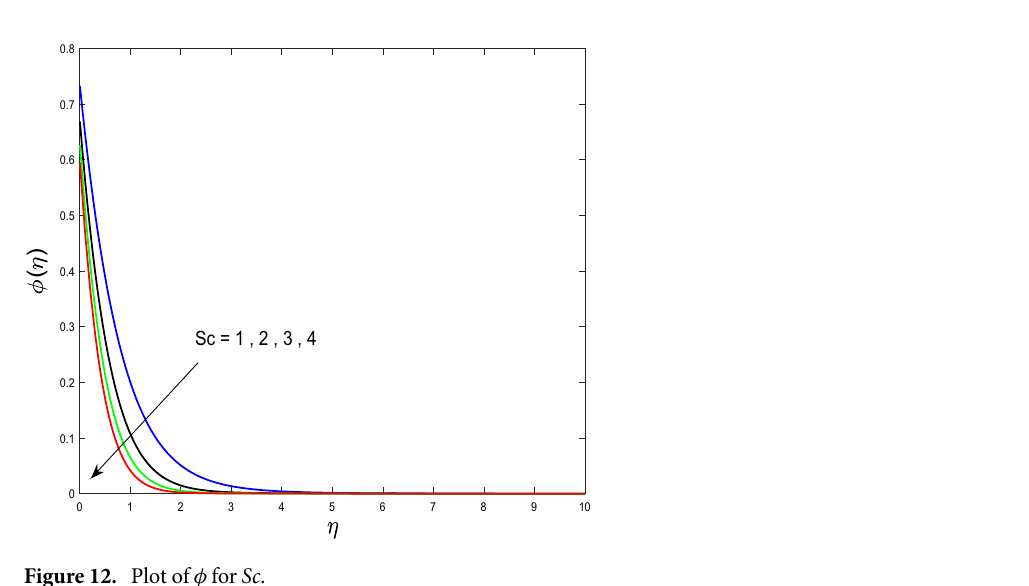
Figure 12. Plot of φ for Sc